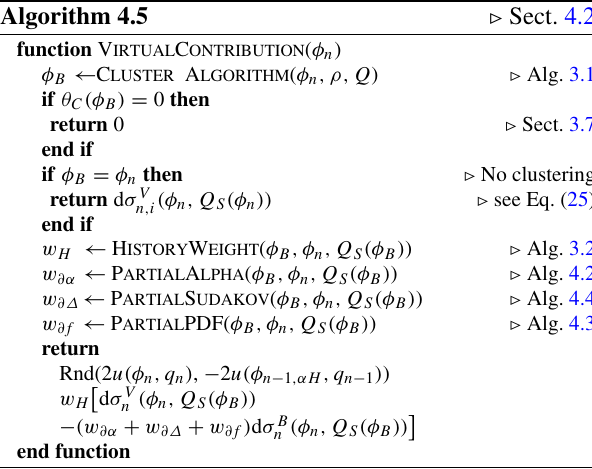
Algorithm 4.2 is generating the contribution in Eq.